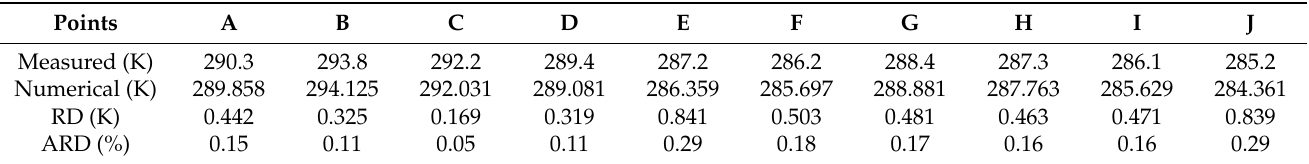
Table 4. The details of the detecting